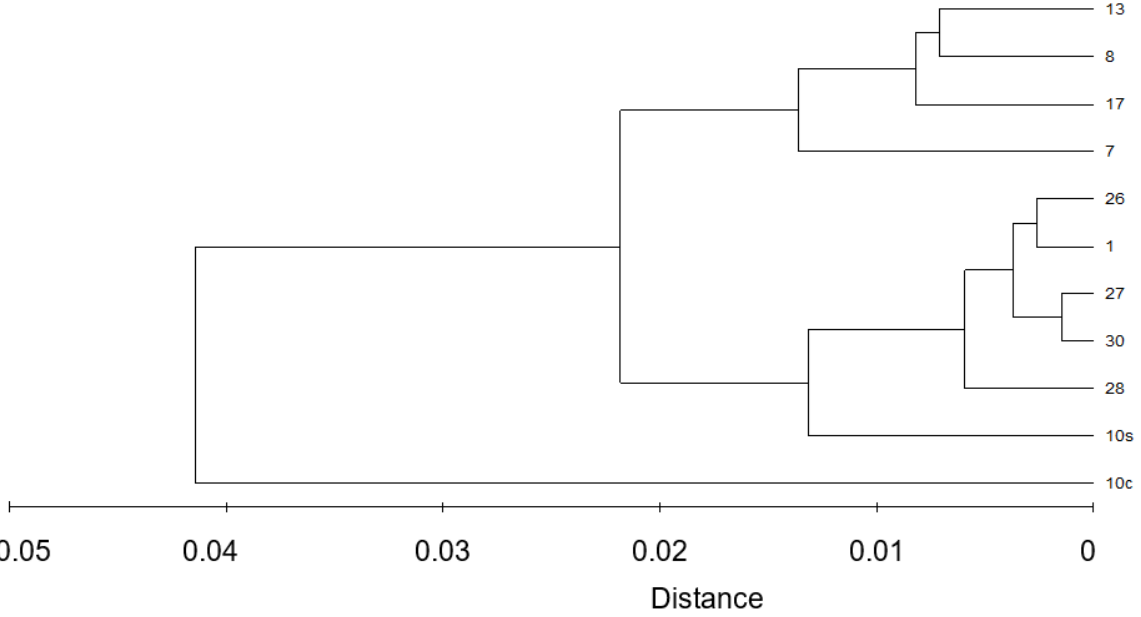
Figure 4. Differences concerning biochemical composition in the selected hauls. Dendrogram relative to MDS analysis applied on biochemical composition data from the two krill species. 10 s = E. superba individuals from haul n. 10; 10c = E. crystallorophias individuals from haul n. 10. High similarity was found among individuals from the same haul (74–88%); dissimilar- ity was higher by species (average 34%) than by differences in latitude (24%) and distance from the coast (22%) (SIMPER, Table S3). MDS analysis found similar results and appeared to identify three groups in terms of biochemical composition (Figure 4): E. crystallorophias from haul n. 10 is the most diverse group; the other two groups are composed of E. crys- tallorophias from hauls n. 7, 8, 13, and 17 and by E. superba from hauls n. 1, 10, 26, 27, 28, and